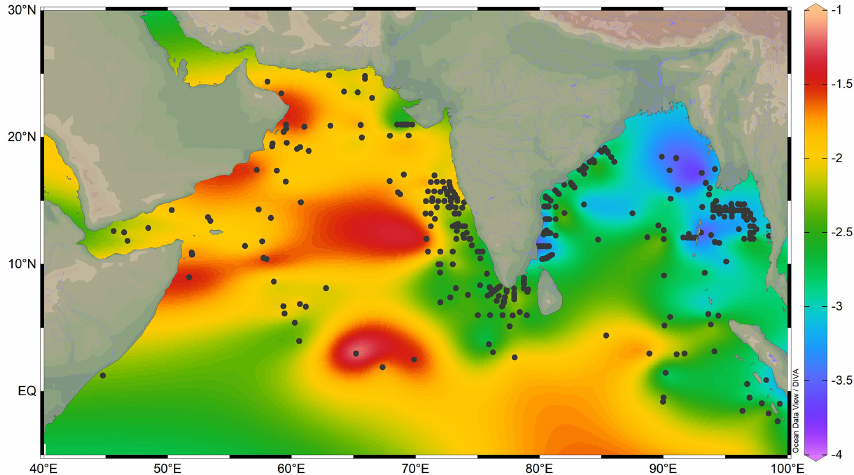
Figure 3. The variation in Globigerinoides ruber δ 18 O (‰) in the surface sediments of the northern Indian Ocean. The stations are marked by a black-filled circle. The lowest δ 18 O ruber is in the riverine-influx-influenced northern Bay of Bengal, and the highest is in the evaporation- dominated central and western Arabian Sea. The major rivers are marked with thin blue lines. The map was prepared by using Ocean Data View software (Schlitzer, 2018).